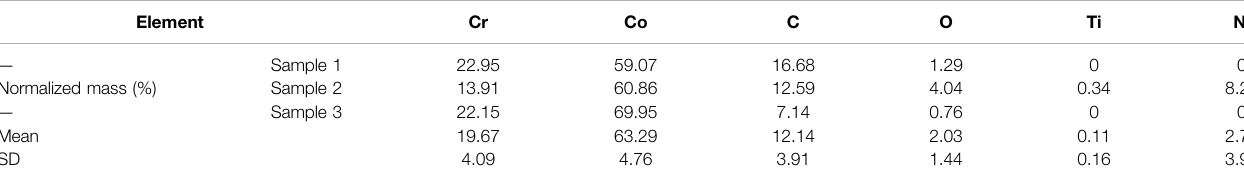
TABLE 2 | Quanti fi ed measurements of the chemical composition of CoCrMo nanoparticles.